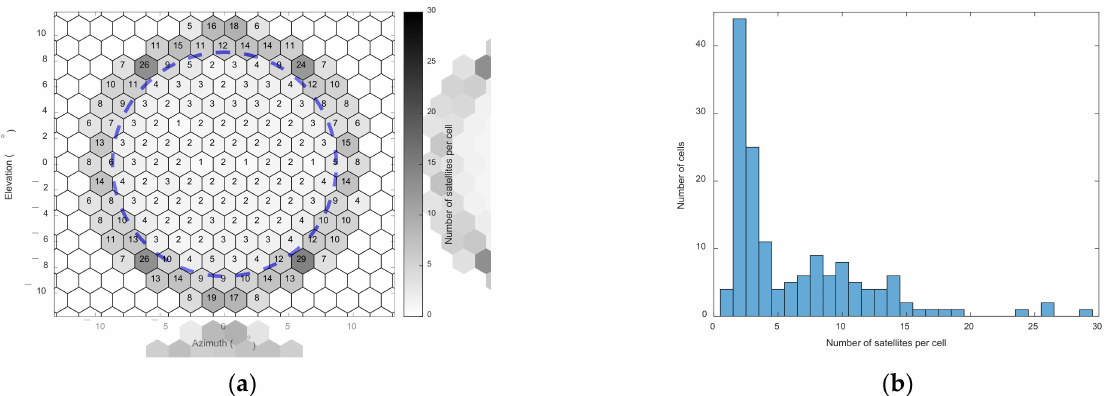
Figure 3. Characteristics of the object distribution in FOV of GEO data relay satellite with 2 ◦ spot beams: ( a ) LEO satellite occupation of spot beams. The number in the center of each cell indicates the transient LEO satellites in the coverage of a certain beam. The blue dash line sketches the contour of Earth’s surface; ( b ) statistics of the cell occupation.